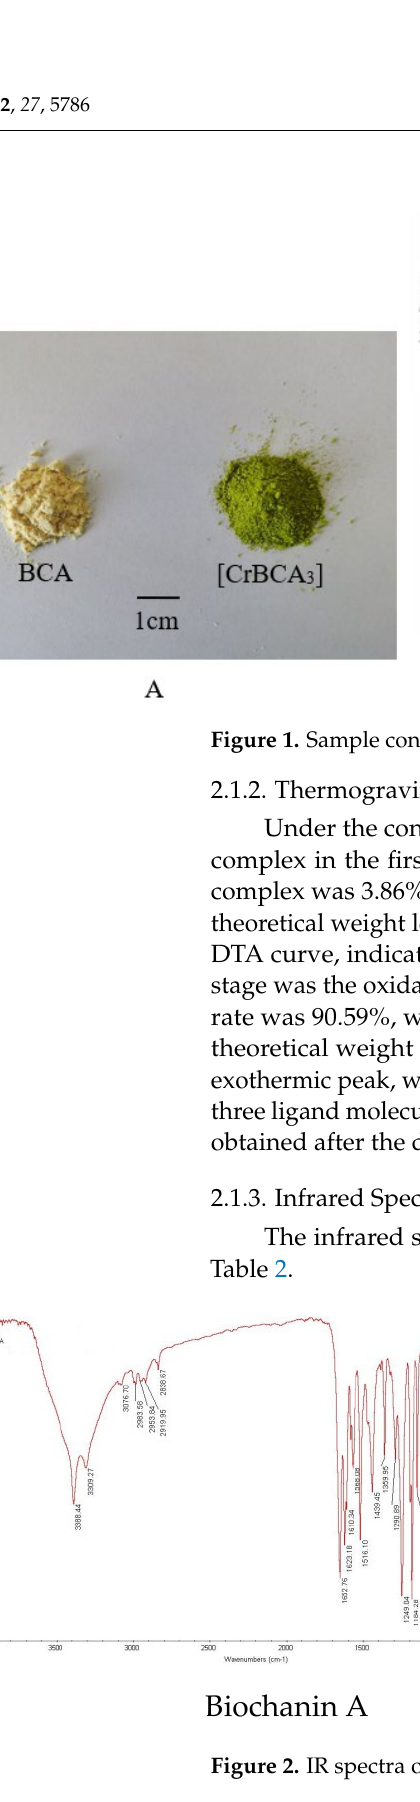
Figure 1. Sample condition and HRMS. ( A ) BCA and [CrBCA 3 ]. ( B ) Mass spectrum of [CrBCA 3 ].